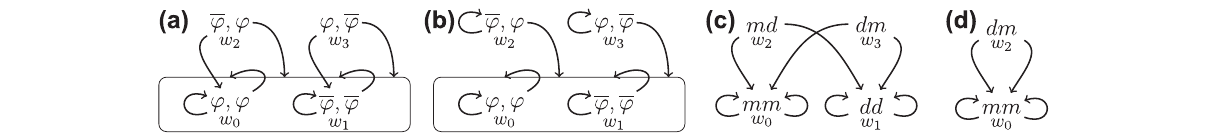
TABLE 9 | Epistemic graphs: (a) , (b) for assertions in scenarios similar to (17); (a) : false belief case, (b) : lying; (c) , (d) for reference in scenarios similar to (13) – (16); (c) : failed joint reference on higher level, (d) : successful joint reference on higher level. Abbreviations: φ a proposition, φ its negation; m : Monkey Business , d : A Day at the Races .